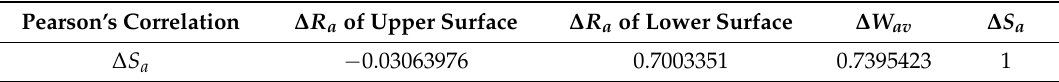
Table 4. Pearson’s Correlation